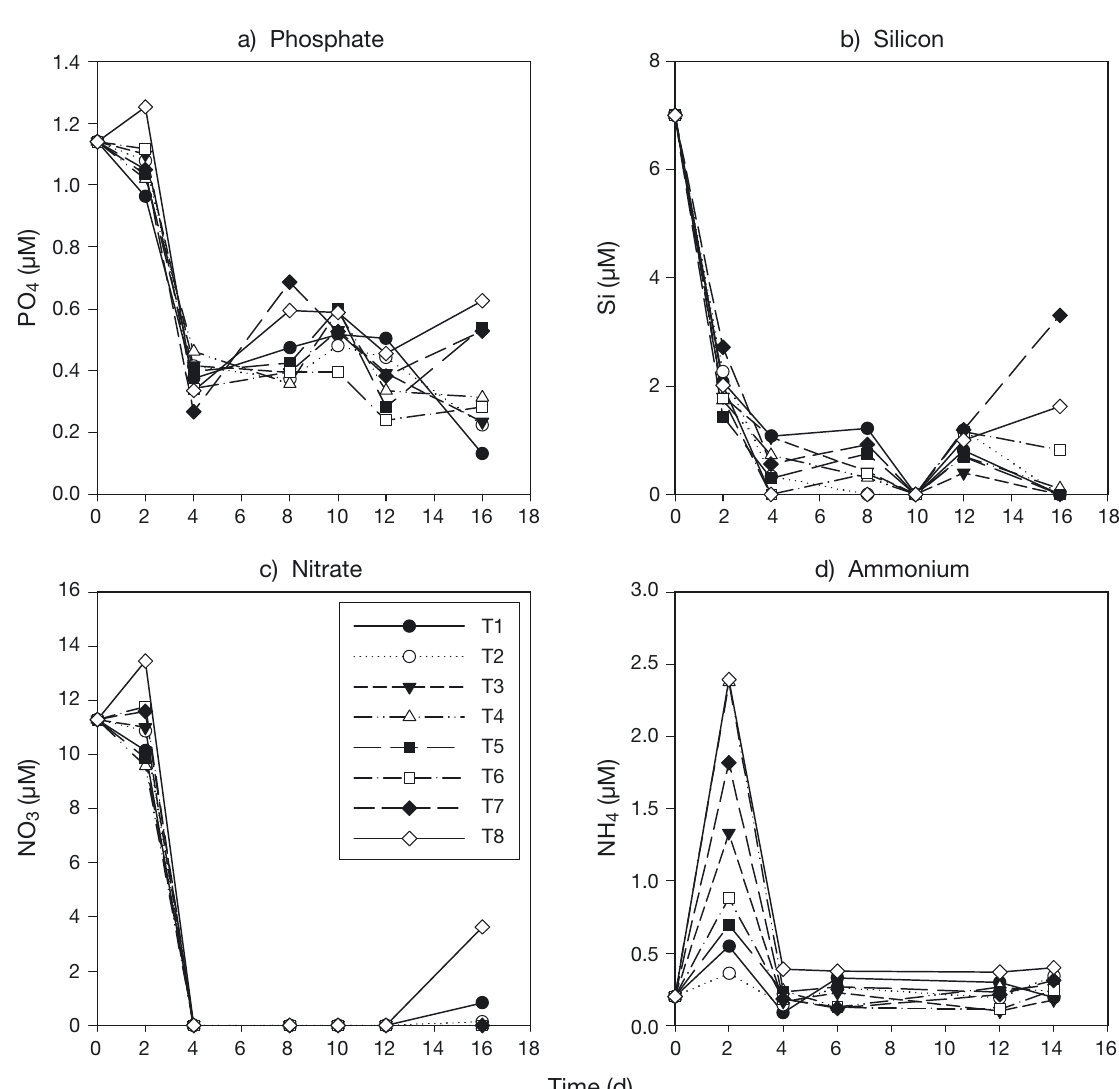
Fig. 2. Development of the average (n = 3) concentration (µM) of (a) dissolved phosphate, (b) silicon, (c) nitrate, and (d) ammo- nium over time in the 8 treatments (T1−T8, see Table 1) of the experiment. The standard errors of the mean were in the range 6−23% for phosphate, 12−82% for silicon, 5−77% for nitrate, and 13−45% for